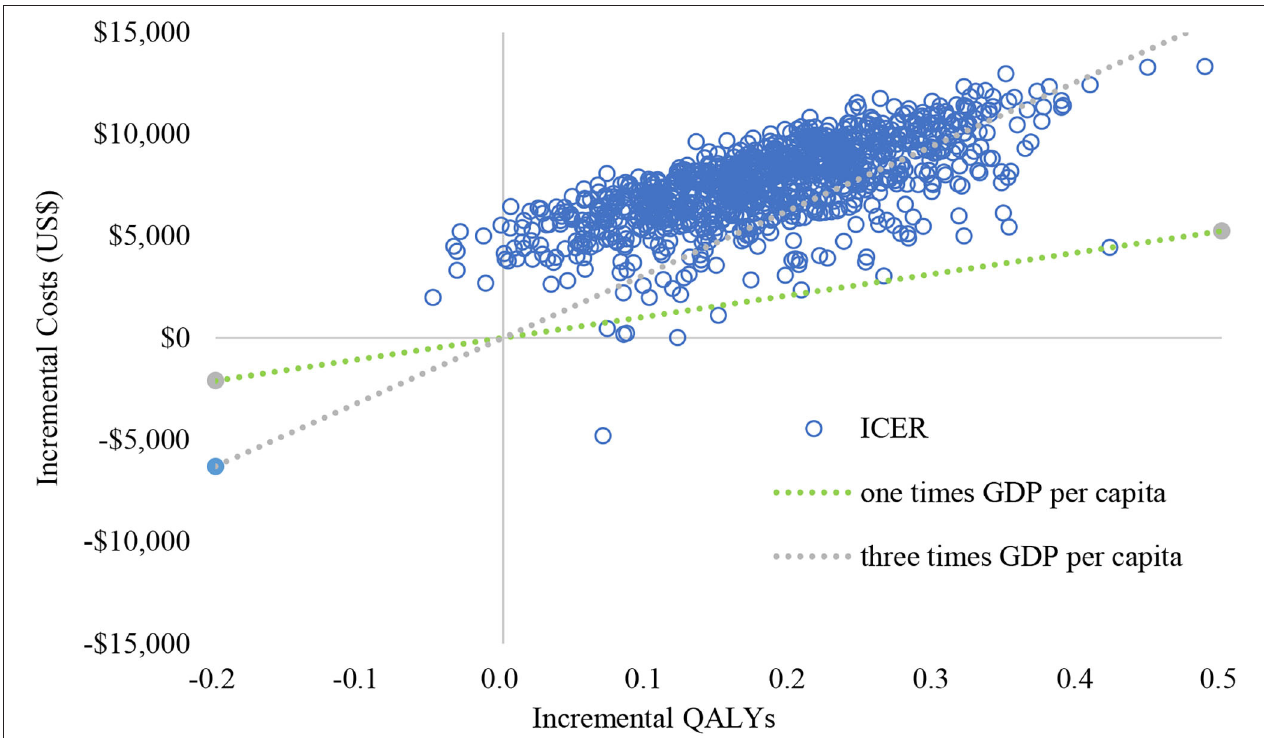
FIGURE 3 | Cost-effectiveness plane of the 1,000 Monte Carlo simulation runs. GDP, gross domestic product; QALY, quality-adjsted life-year; ICER, incremental cost-effectiveness ratio. conducted across 37 centers in China, and its efficacy and safety results were similar to the actual situation of patients with advanced HCC in China (5). Although similar PFS outcomes between donafenib and sorafenib were observed in ZGDH3 and via extrapolation, a significantly longer OS duration led to more QALYs gained with